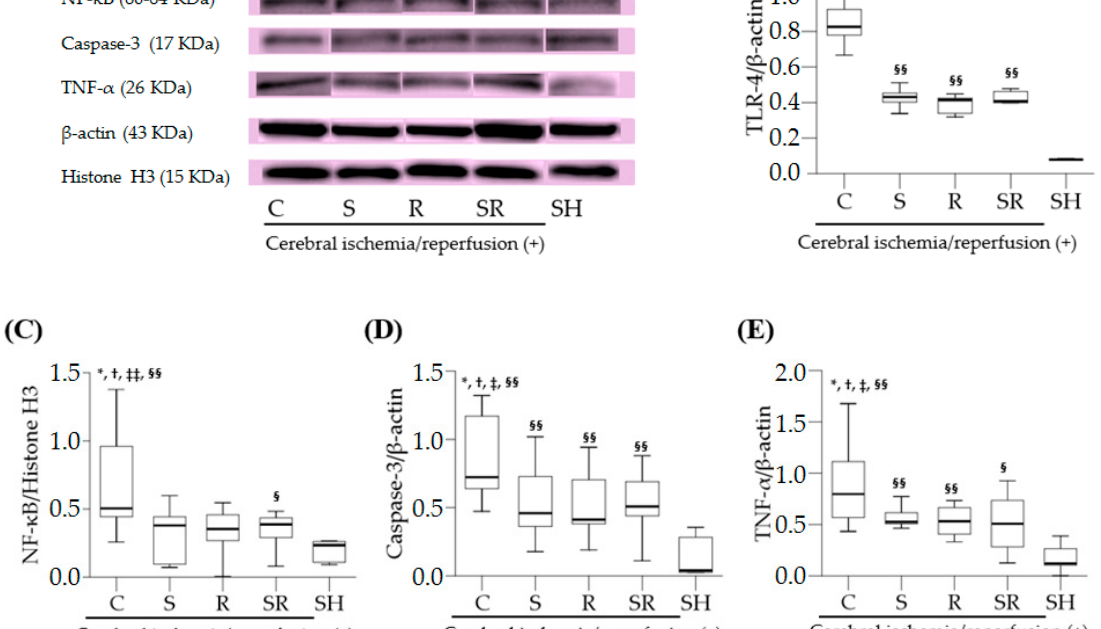
Figure 4. Serum levels of ( A ) tumor necrosis factor-alpha (TNF- α ), ( B ) interleukin-6 (IL-6), and ( C ) interleukin1 beta (IL-1 β ) measured 24 h following transient global cerebral ischemia and assayed by ELISA. ** p < 0.01 for Group S; †† p < 0.01 for Group R; ‡‡ p < 0.01 for Group SR; §§ p < 0.01 for Group SH. 3. Discussion This study shows that sevoflurane postconditioning decreased inflammation by inhibiting the TLR-4/NF- κ B pathway and subsequent TNF- α expression in brain tissue after transient global cerebral I/R injury in rats. In addition, sevoflurane postconditioning reduced the expression of caspase-3 in the brain as well as serum levels of pro-inflammatory cytokines in peripheral blood. Inflammation is a crucial mechanism involved in the pathophysiology of cerebral I/R injury. Inflammation occurs in the early phase of cerebral I/R injury and can further aggravate neuronal